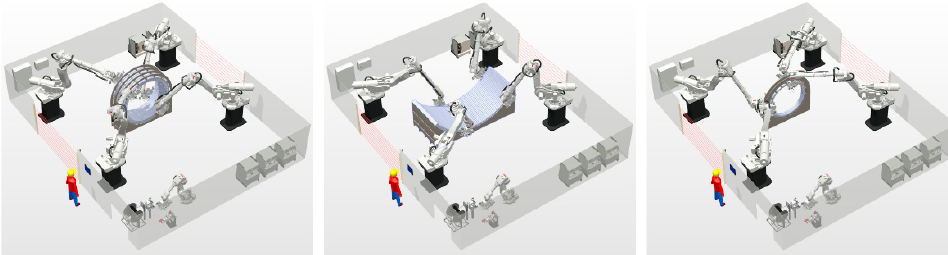
Figure 6. Graphical illustrations from simulations of the robotized stator cable winding of the larger rotating electric machine designs S1a ( left ), S1b ( middle ) and S1c ( right ). Robot reach and placement in the cell were critical for achieving the desired positioning against all slots on the stators, due to the large variation in stator dimensions. Smaller robots and cell designs were possible for winding only S1a and S1c. It was necessary to synchronize the work of the winding robot pairs—the second pair starting 90° after the first pair with full round stators—to avoid robot collision and cable tangling. The winding was performed in both directions, starting and ending at the bottom slots for S1a and S1c. For S1b, the winding started at the bottom slot and ended at the ends of the stator section. Robot positioning relative to the stator slots was performed with the cable feeder tools directed radially from the inside or outside of the stator—with respect to the robot axis configuration—to avoid cable twisting as the end windings were pulled, hence tool rotation to vertical was required when dropping the cable; see Figure 7.